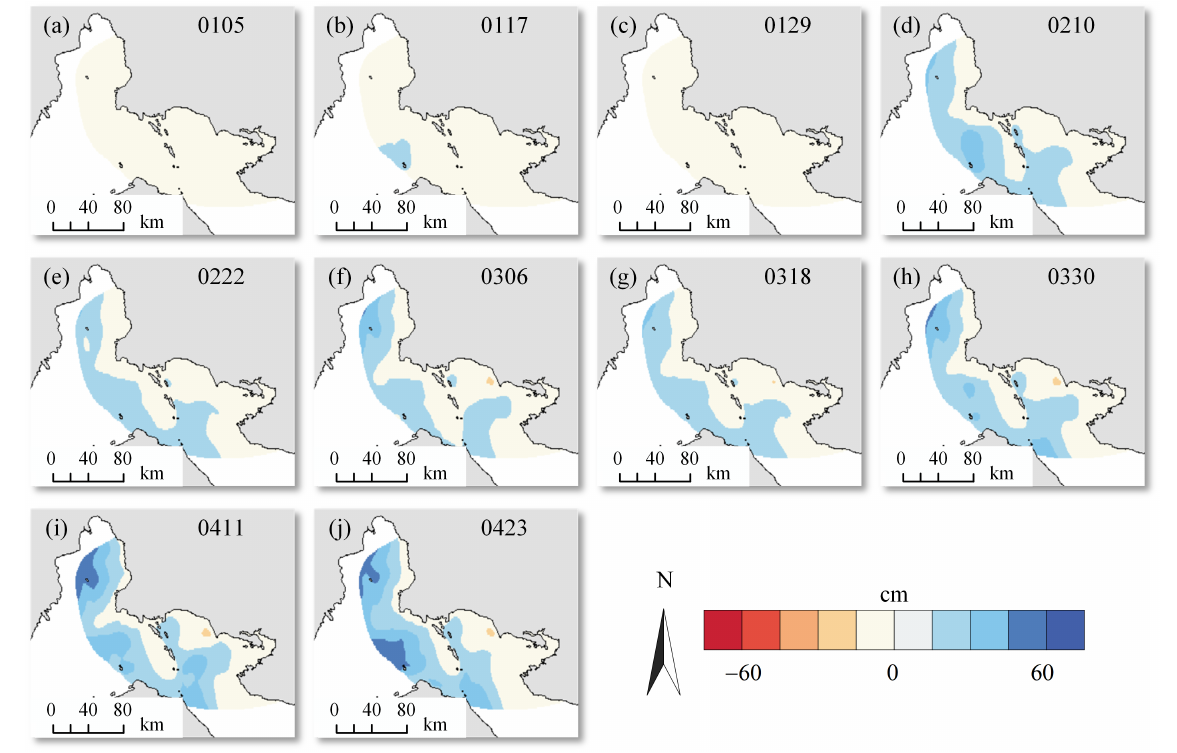
Figure 8. Retrieved time-series horizontal deformation from January 2021 to April 2021: the top-right number of subfigures ( a – j ) represents the corresponding SAR images acquisition dates.